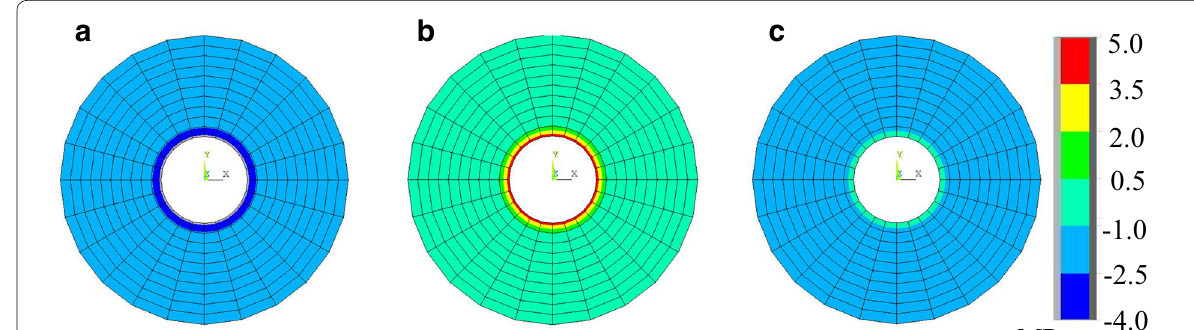
Fig. 10 Stress concentration effects: a S loading; b P loading; c S